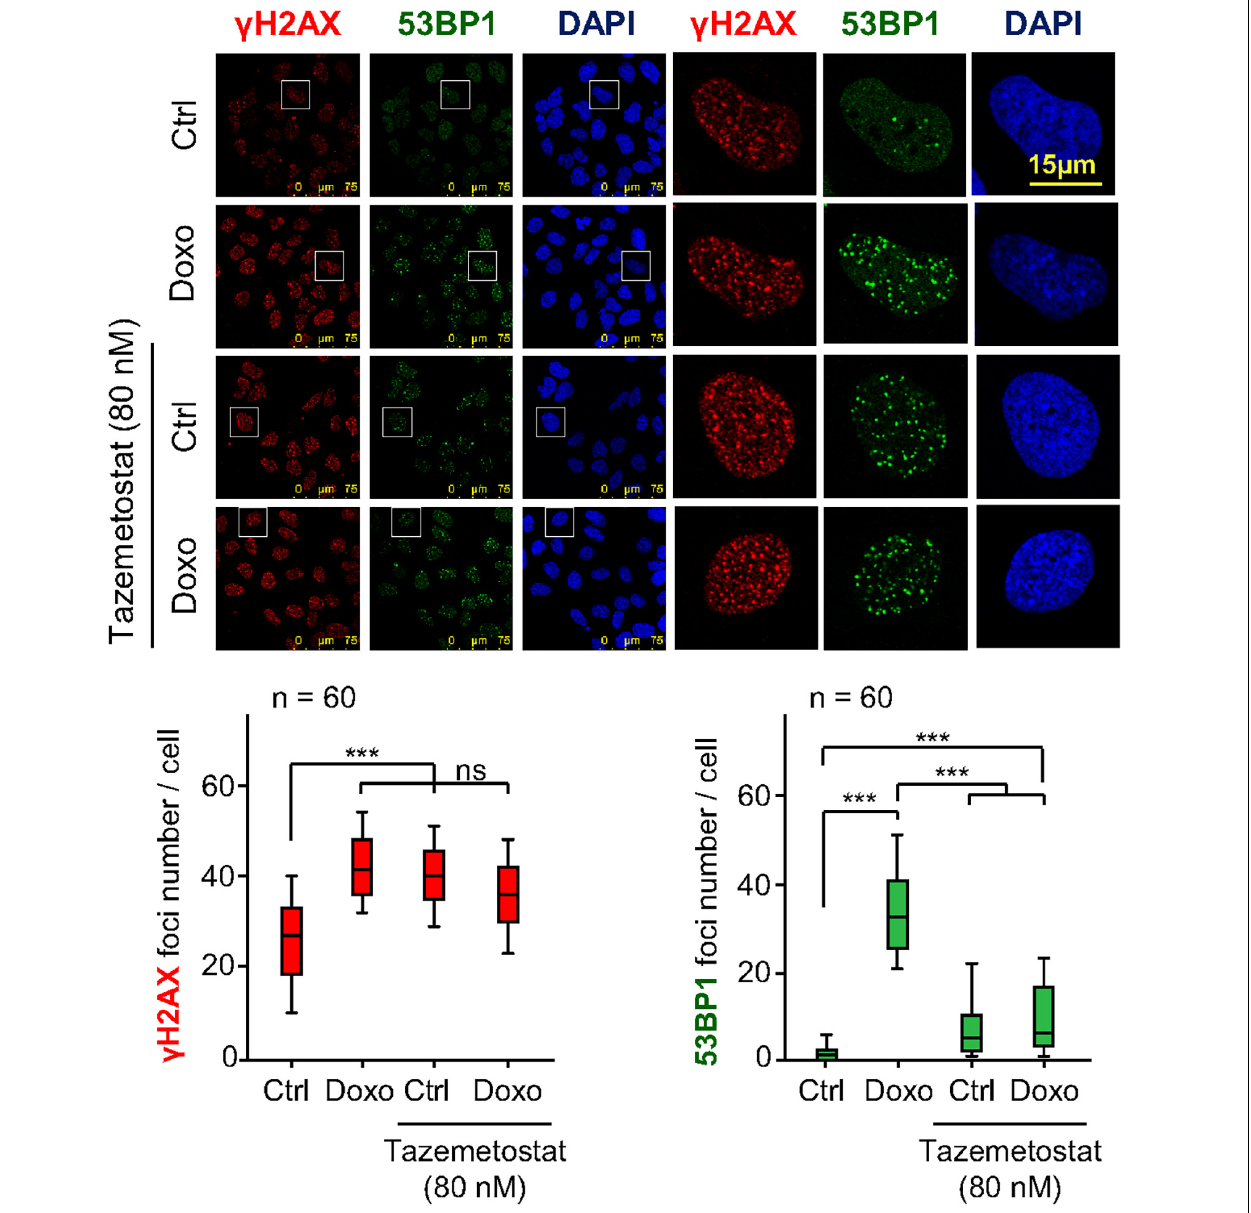
FIGURE 7 | Effect of tazemetostat on γ H2AX and 53BP1 foci in response to doxorubicin treatment in U2OS osteosarcoma cells deprived of serum. Effect of tazemetostat on the formation of γ H2AX (red) and 53BP1 (green) foci. The detail images selected indicated by boxes are shown to the right. Graphs at the bottom show the quantification of γ H2AX and 53BP1 foci. ns, not significant. *** p < 0.001. Ctrl, control without